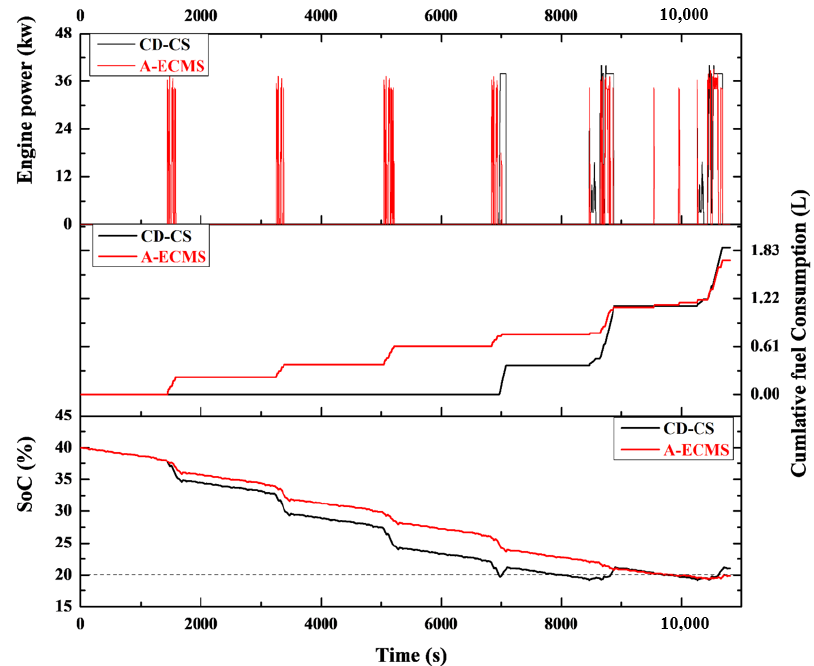
Figure 14. Vehicle velocity within the real driving cycles in the study.